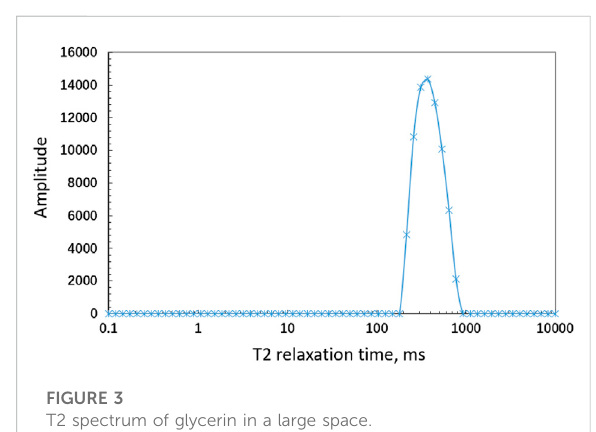
FIGURE 2 Comparisons of threshold pressure gradient of different blocks.